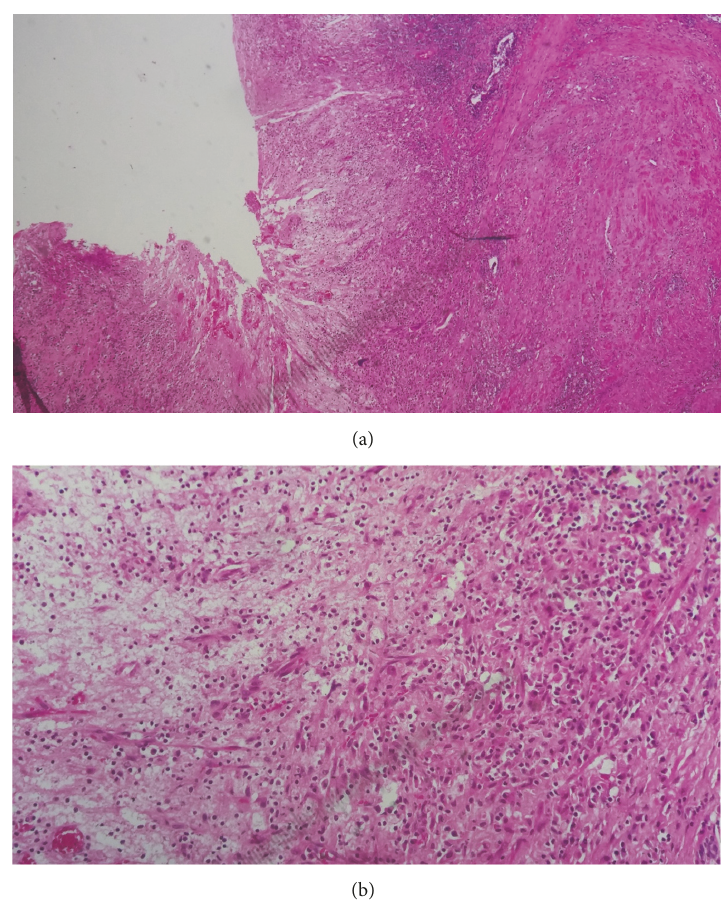
Figure 4: Microscopic view of resected specimen. (a) Prostatic parenchyma seat of an abscessed collection bordered by a polymorph inflammatory infiltrate. (b) Xanthomatous infiltrate rich in foamy histiocytes without presence of gigantocellular or epithelioid